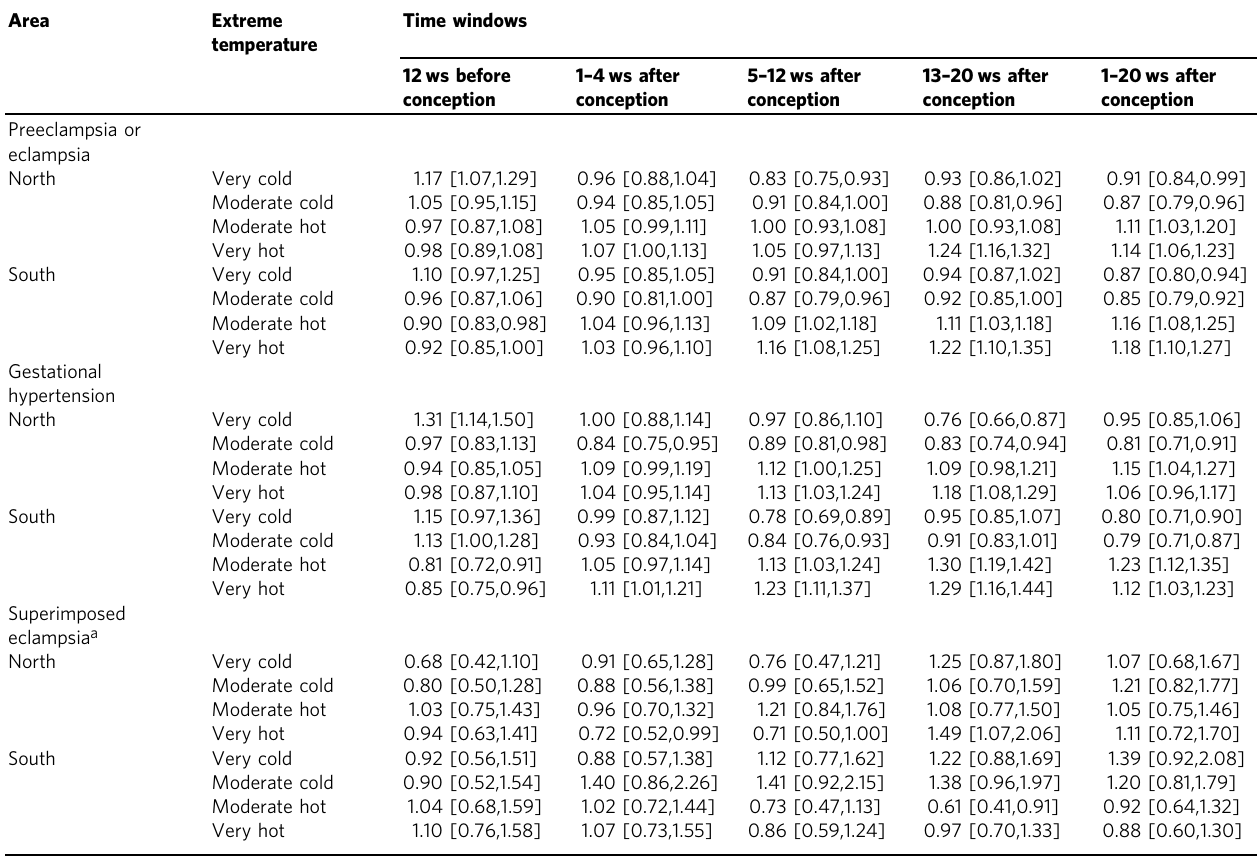
Table 2 Odds ratio of extreme temperature exposed and subgroups of hypertensive disorders in pregnancy.